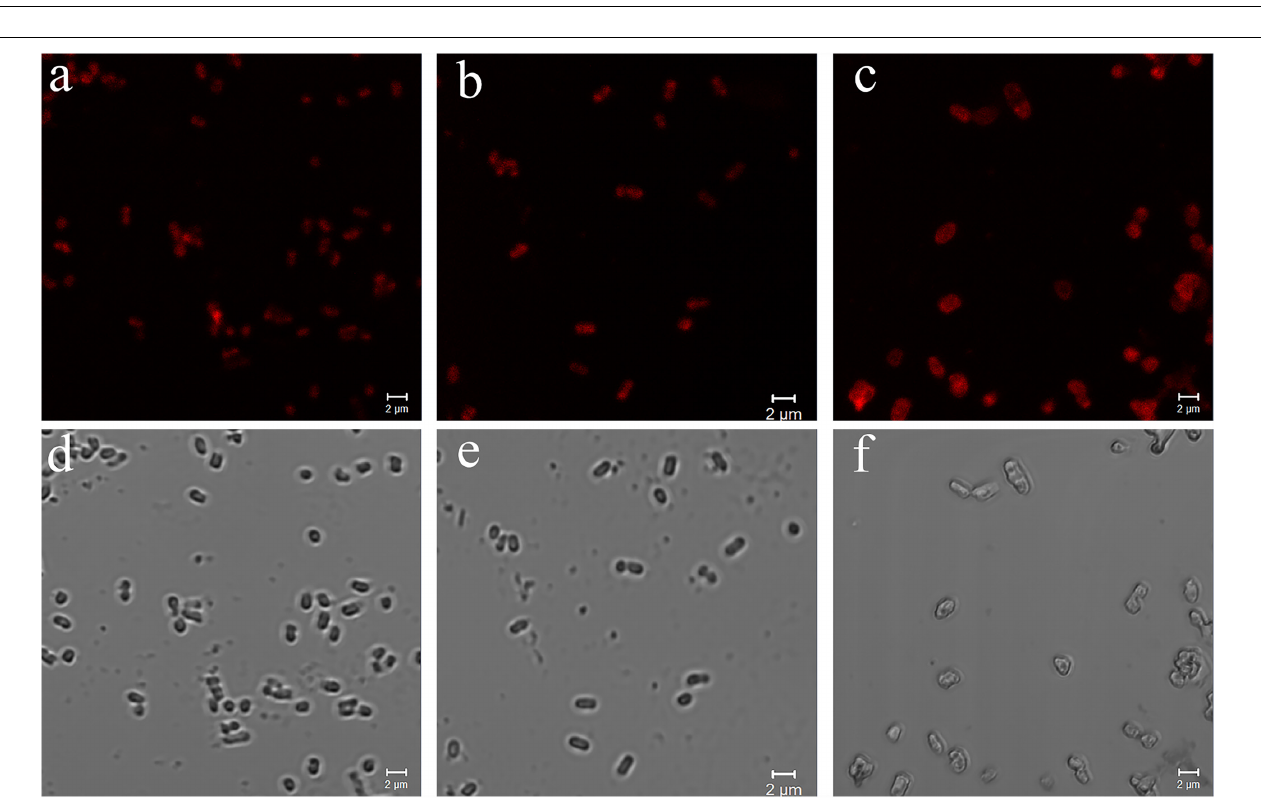
FIGURE 5 | Phototoxicity and dark toxicity of PPIX-MED against (A) three bacterial strains and (B) NIH 3T3 (mouse fibroblast) cells. Each bacterial species and the fibroblasts were respectively incubated with PPIX-MED (0–31.25 µ M) for 30 min, followed by exposure to 650-nm laser light (6 J/cm 2 ) or darkness. The results are expressed as mean and standard deviation.